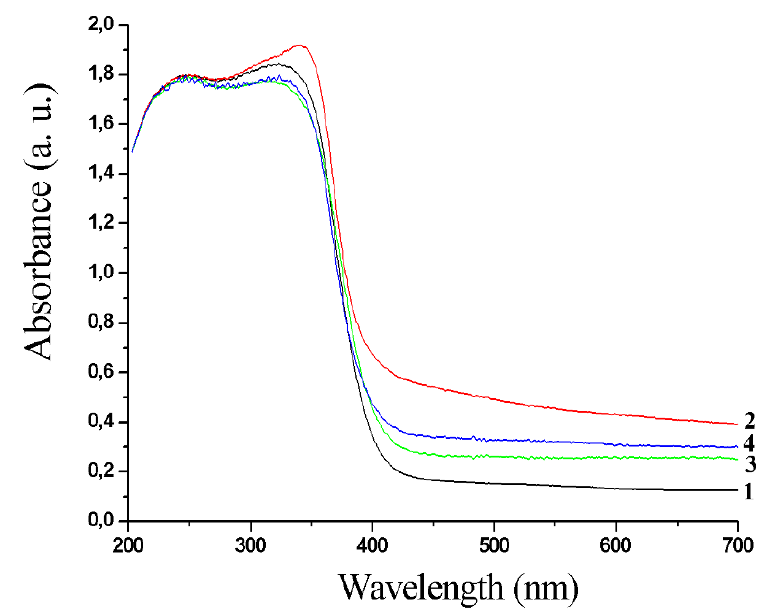
Figure 2. UV-Vis absorption spectra of TiO